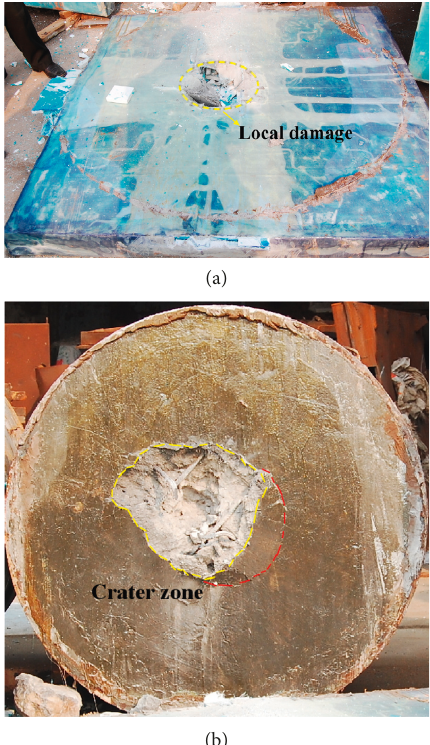
Figure 14: Damage results of FC-RPC target 2: (a) damage of the FC target; (b) damage of the RPC target.